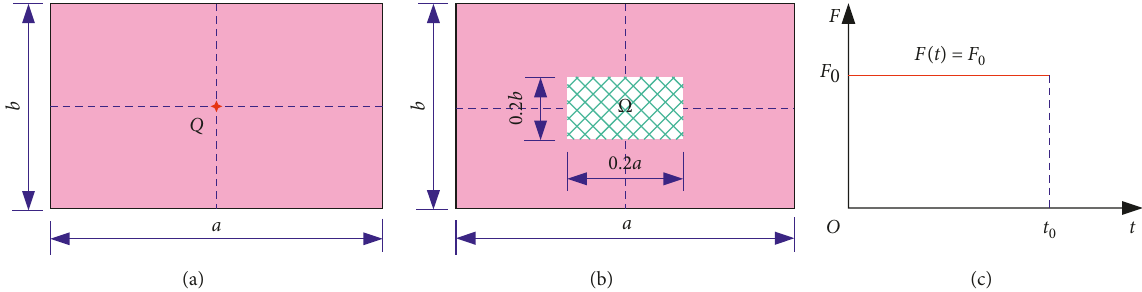
Figure 2: External load types for the stiffened plates: (a) point force, (b) surface force, and (c) rectangular